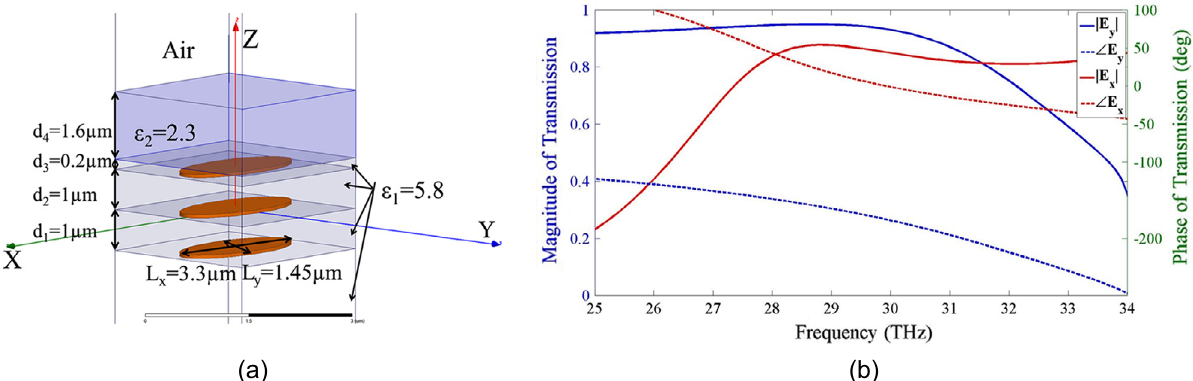
Figure 2. (a) The unit cell design of the half-wave plate that comprises three metallic elliptical patches and interlayer dielectrics, (b) transmission of the half-wave plate design for the X and Y polarizations.